Question: Which kind of chart has been used to present this data?
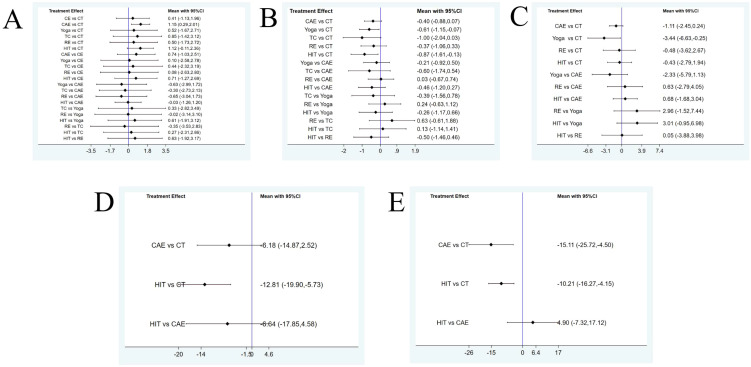
Answer: forest